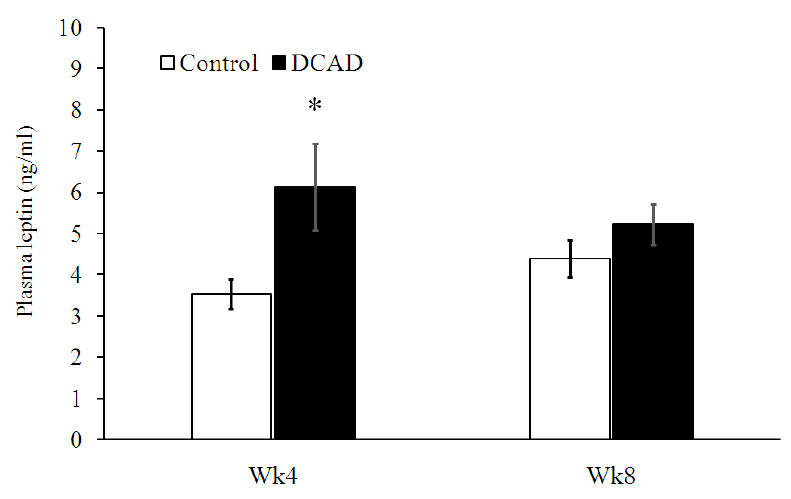
Figure 3. Effect of dietary cation and anion difference (DCAD) on plasma leptin concentration in lactating dairy goats at 4th and 8th weeks postpartum. The DCAD levels from DCAD-23 and DCAD-39 groups were 22.8 and 39.1 mEq/100 g DM, respectively. Asterisks indicate the significant differences within each period, *